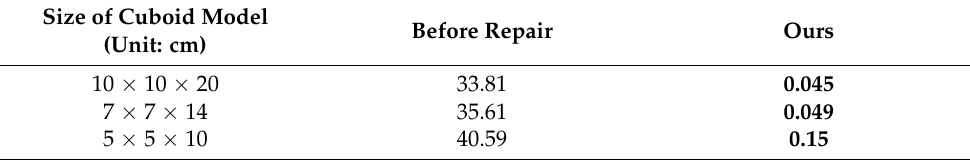
Table 2. The chamfer distance for cuboid point cloud models with different sizes before and after